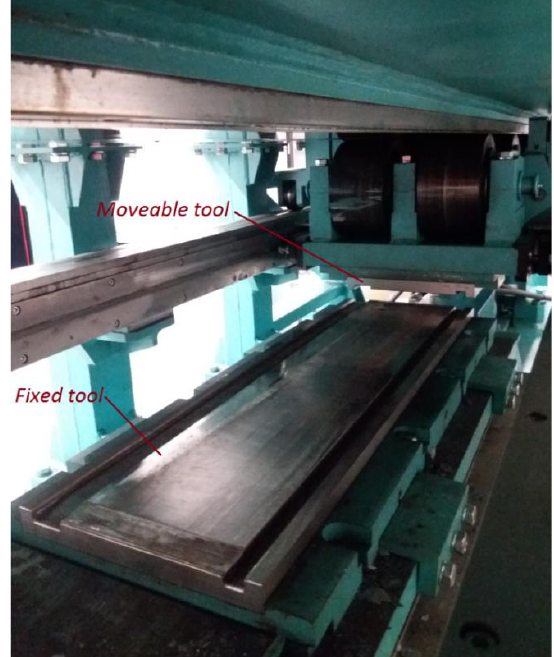
Figure 2. The working zone of a cross-rolling mill adapted to conduct the rotational compression of cylindrical samples.